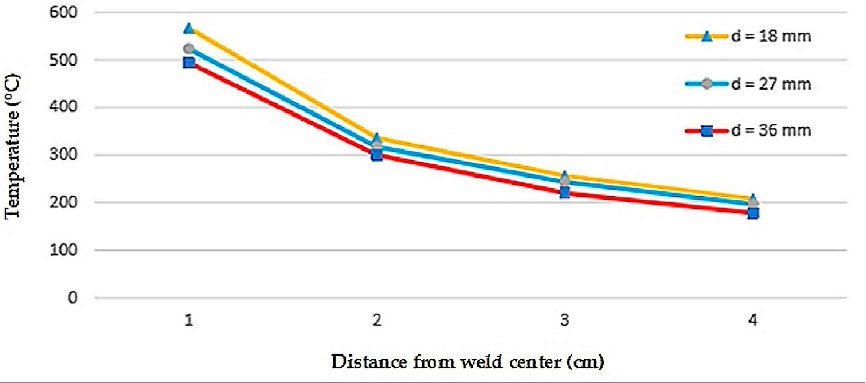
Figure 5. Peak temperature of tandem MIG welding.